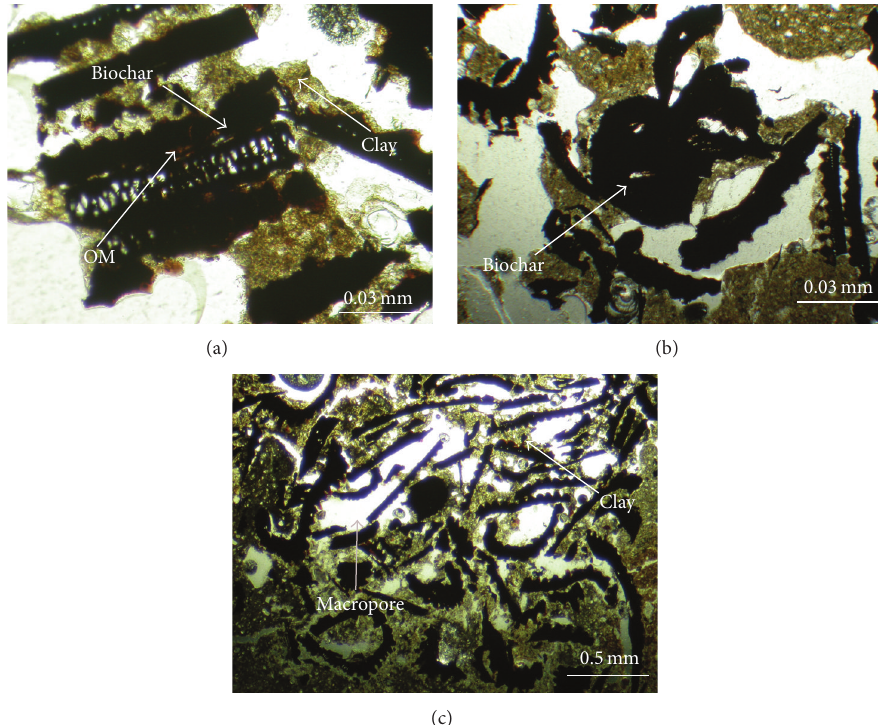
Figure 4: Micrographs of thin sections of soils amended with biochar: (a) soil aggregates with 5% application rate of RHB-400 with plain polarized light (PPL); (b) soil aggregates with 5% application rate of RHB-700 with plain polarized light (PPL); (c) soil aggregates with 10% application rate of RHB-700 with plain polarized light